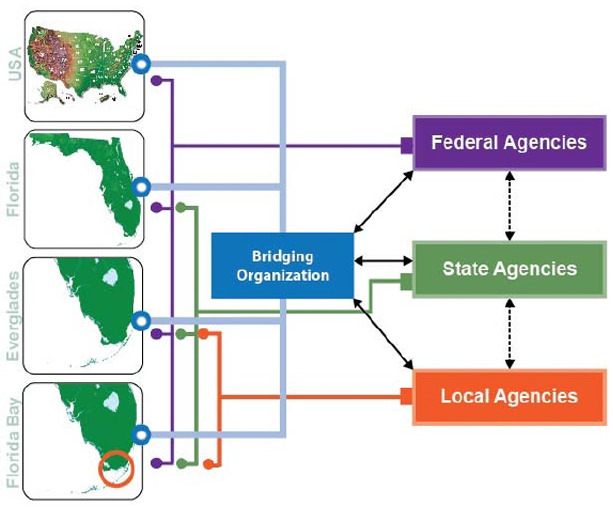
Fig. 2 . Environmental governance of the Florida Bay: the combination of panarchy, adaptive management and adaptive governance, and reflexive law. In this panarchy, the United States is at the top scale, Florida the next scale, followed by the Everglades, and then Florida Bay at the smallest ecological scale. Federal, state, and local management agencies are linked to their scales of governance, and an intermediary, e.g., bridging organization, is offered as the vehicle to fill gaps in “scale- matching,” and to facilitate communication and information flow. Map of USA (www.usgs.gov/state); Map of Florida